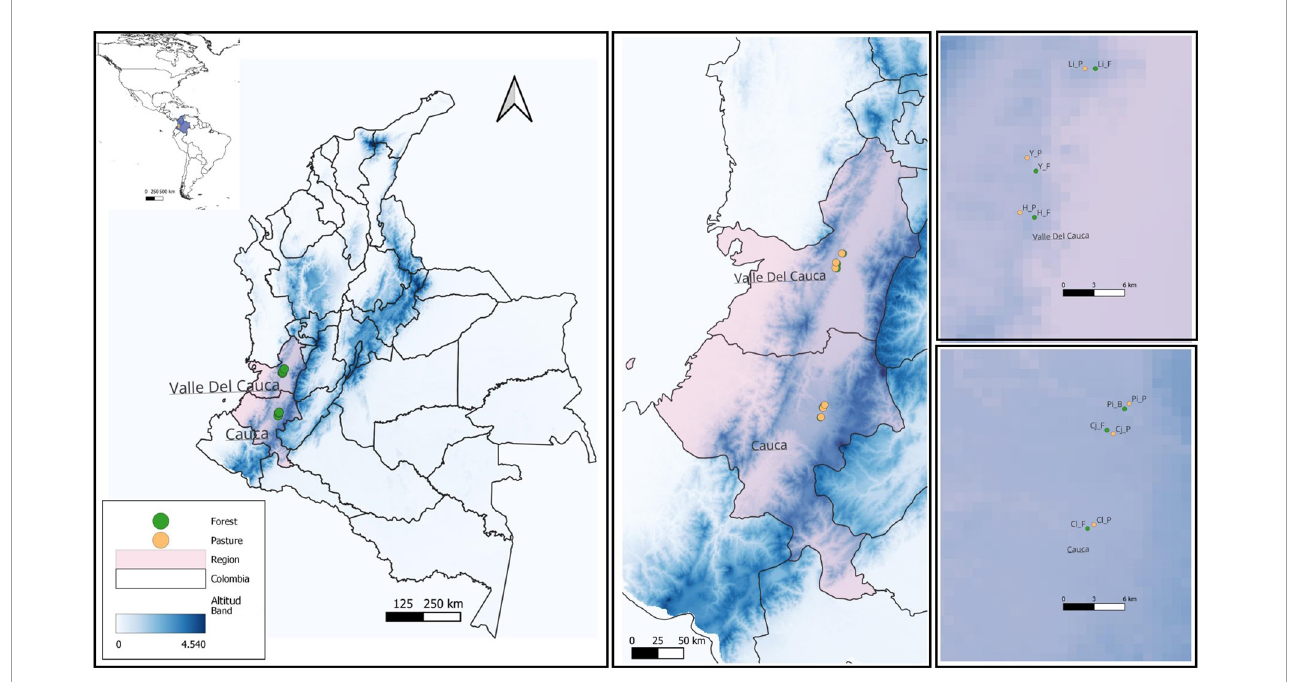
FIGURE1 Geographical location study sites and experimental design showing sampling organization over three scales, Region: Cauca and Valle. Site: Cl, Calibío; Cj, Cajibío; Pi, Piendamó; H, Hondonada; Li, Lilas; Y, Yotoco. Sub-site: F, forest; P,